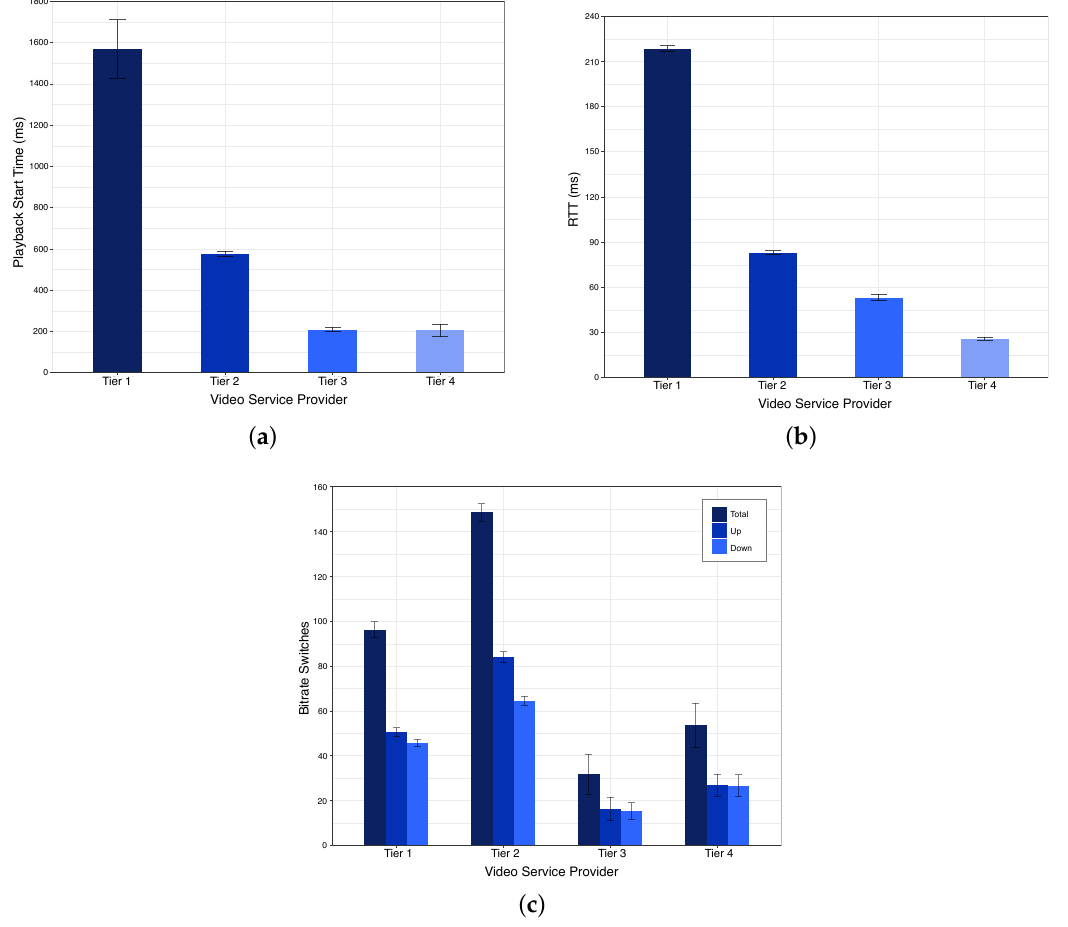
Figure 5. Experimental Results of ABR Schemes Deployed at Different Tiers of the Proposed Architecture. ( a ) Playback Start Time; ( b ) RTT; ( c ) Number of Bitrate